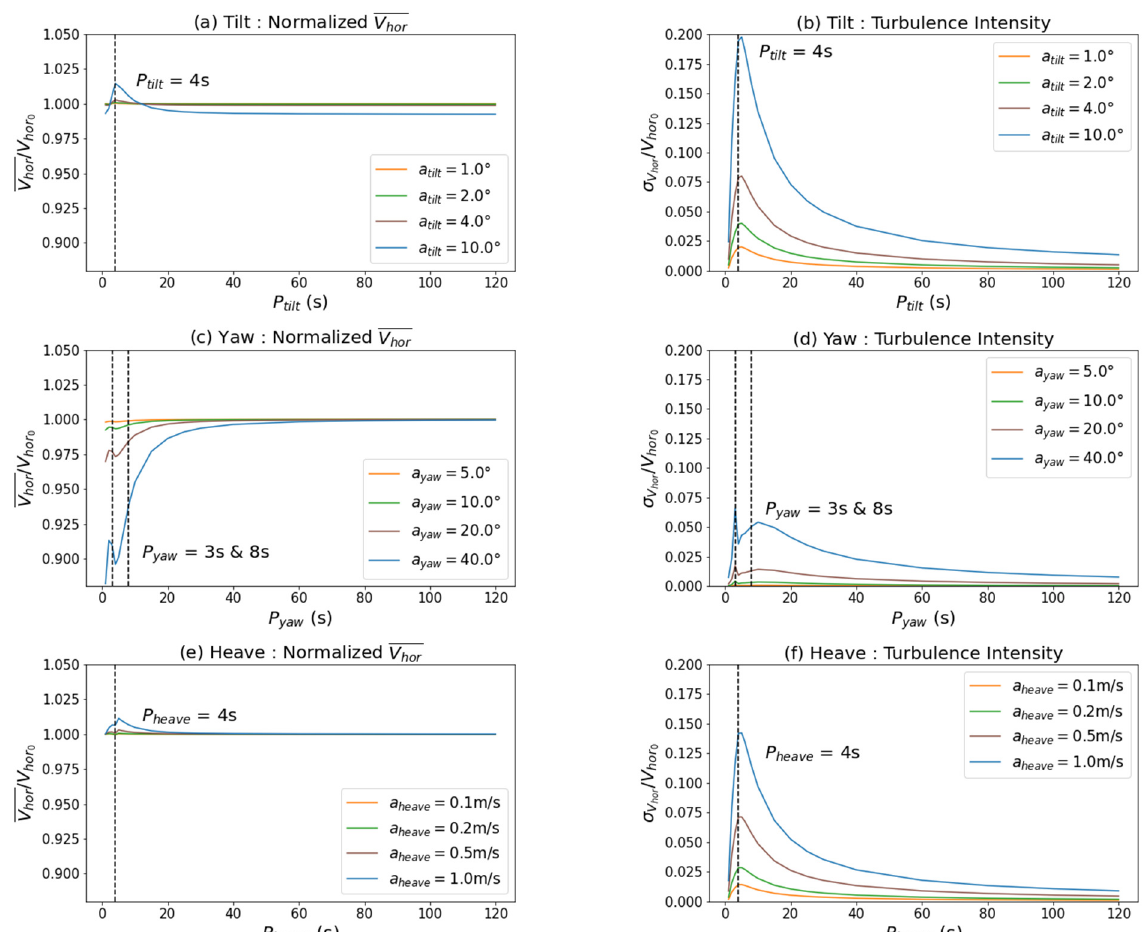
Figure 10. Influence of the period of a sinusoidal motion on the mean horizontal velocity and its standard deviation estimated by the model and normalized by the incident horizontal velocity V hor . The periods having the greatest impact on the LIDAR measurement, called resonance period, are specified. ( a , b ) LIDAR subjected to a sinusoidal tilt motion for an incident wind along the component perpendicular to the axis of rotation. ( c , d ) LIDAR subjected to a sinusoidal yaw motion. ( e , f ) LIDAR subjected to a sinusoidal heave motion.